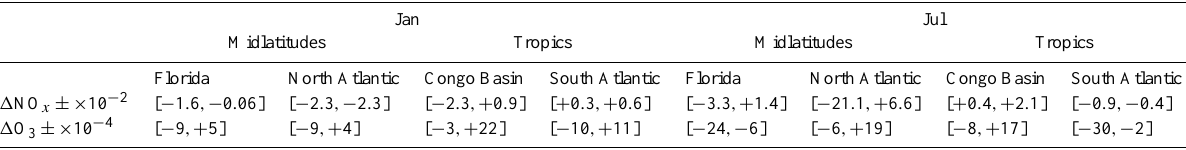
, performed with the i